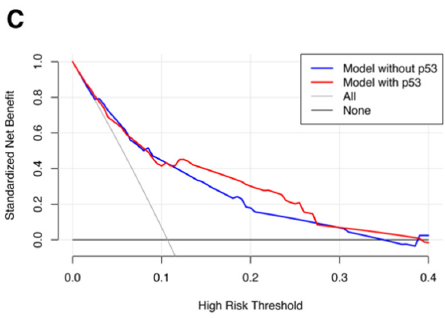
Figure 5. DCA of the ( A ) model with p53; ( B ) without p53. ( C ) Comparison between the models with and without p53. Abbreviations: DCA, decision curve analysis.